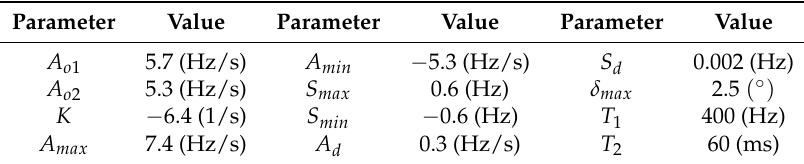
Table 5. Scheme parameters.